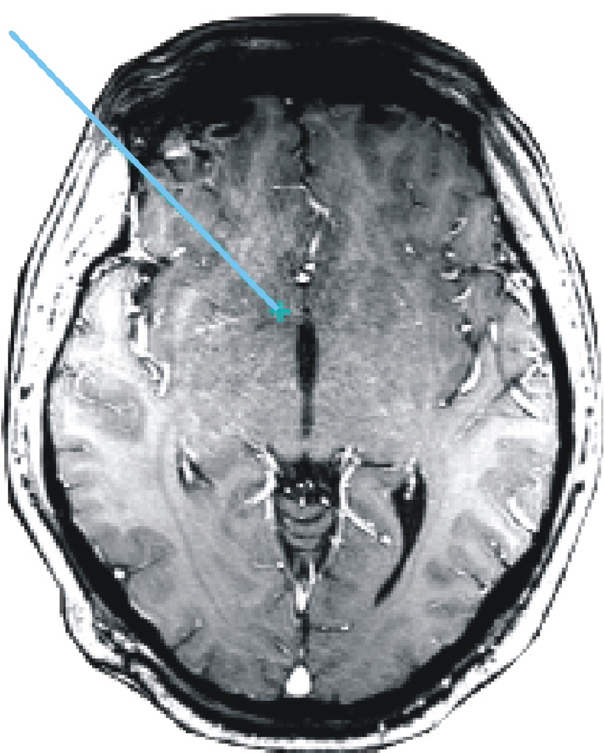
Figure 3. Location of the electrode. MRI scan showing the trajectory and tip of the DBS electrode within the Nucleus accumbens.